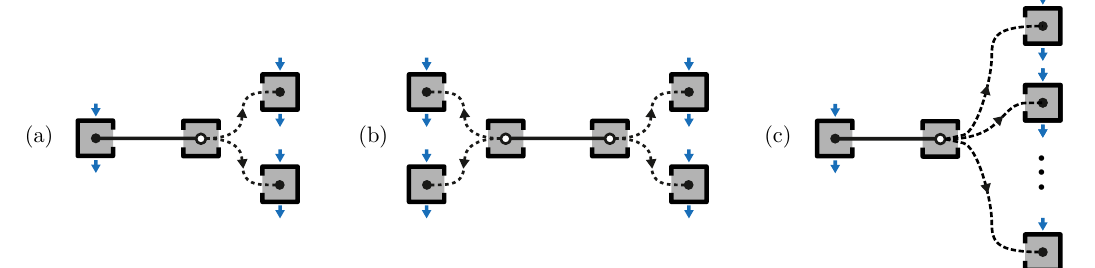
Figure 1: Three broadcast scenarios. One (or more) of the local systems is broadcast via the application of a quantum channel, resulting in a multipartite state, sent to distant parties. Local measurements are then performed on this state, and the resulting statistics are used to rule out a local hidden-variable description for the original bipartite